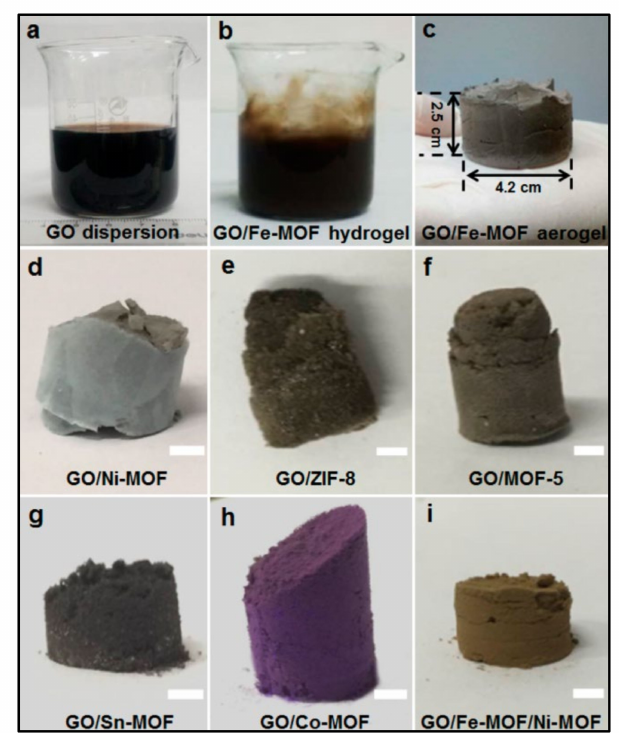
Figure 3. Photographs of GO dispersion ( a ), GO/Fe-MOF hydrogel ( b ), GO/Fe-MOF aerogel ( c ), and other GO/MOF composite aerogels ( d – i , scale bar = 0.35 cm) [31]. Reprinted (adapted) with